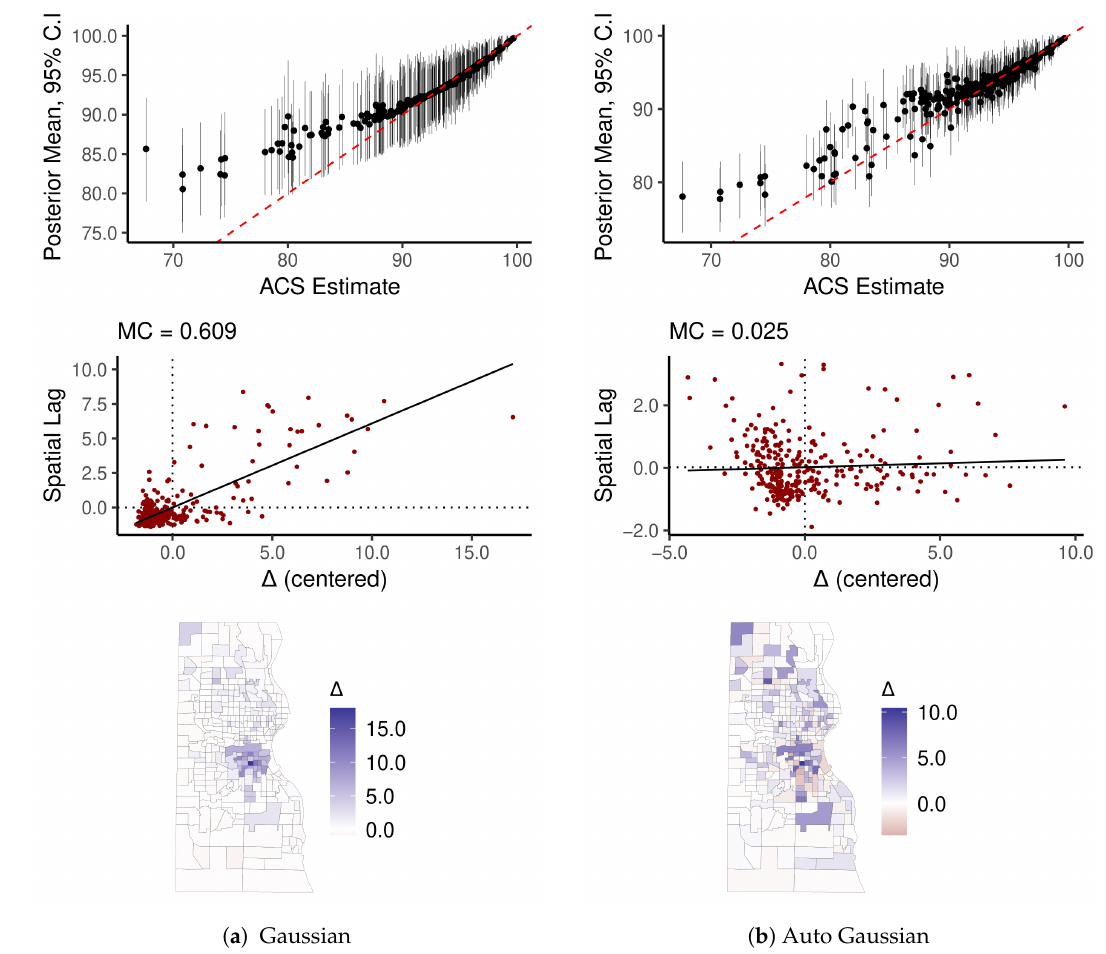
Figure 6. Diagnostics for observational error models of percent insured by Milwaukee County census tract. ∆ is the difference between posterior means and their respective raw ACS